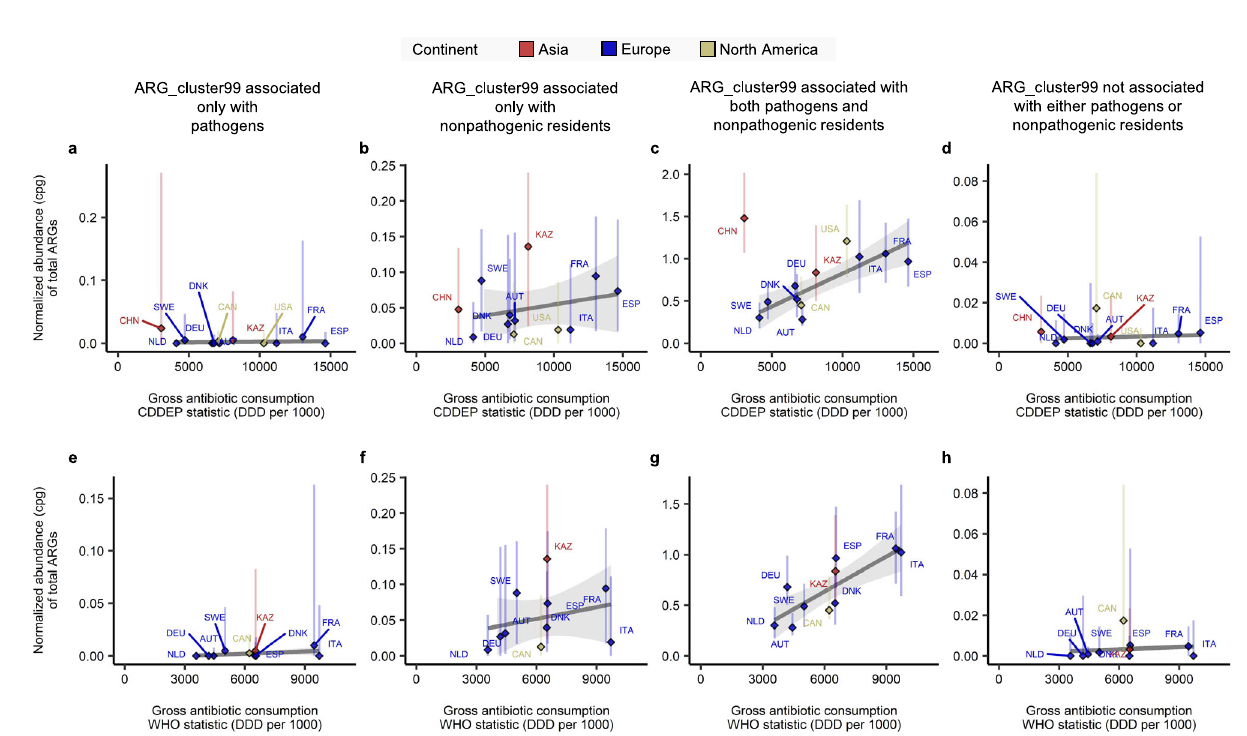
Fig. 5 | Correlation between median total abundance of ARGs deriving from different speciestypesand antibiotic consumption rates. ARG_cluster99s were assigned to four categories based on the presence of ORFs from pathogens (see de fi nition in text) and non-pathogenic residents (non-pathogenic found in atleast 10%ofthestoolmetagenomesofhealthyadultsnottakingantibiotics). a , b , c , d We display correlations between the median ARG abundance (cpg) summed for each speciescategoryandthepercapitarateofantibioticconsumption(DDDper1000) in each country using CDDEP statistics. Pearson ’ s correlation a r=0.19, p =0.58; b r=0.25, p =0.46; c r=0.81, p =2.6e-3; d r=0.11, p =0.76. In e , f , g , h weused the WHO antibiotic consumption. Pearson ’ s correlation e r=0.44 p =0.2; f r=0.26, p =0.61; g r =0.81, p =4.2e-3; h r=0.14, p =0.69.Diamondsgivethemediansofthe